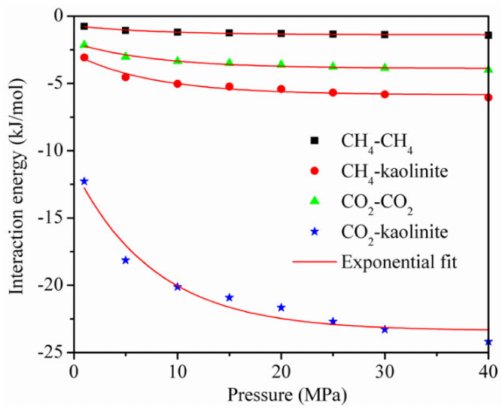
Figure 8. The interaction energy between the adsorbent and adsorbate and between the adsorbate and adsorbate at the temperature of 293.15 K.